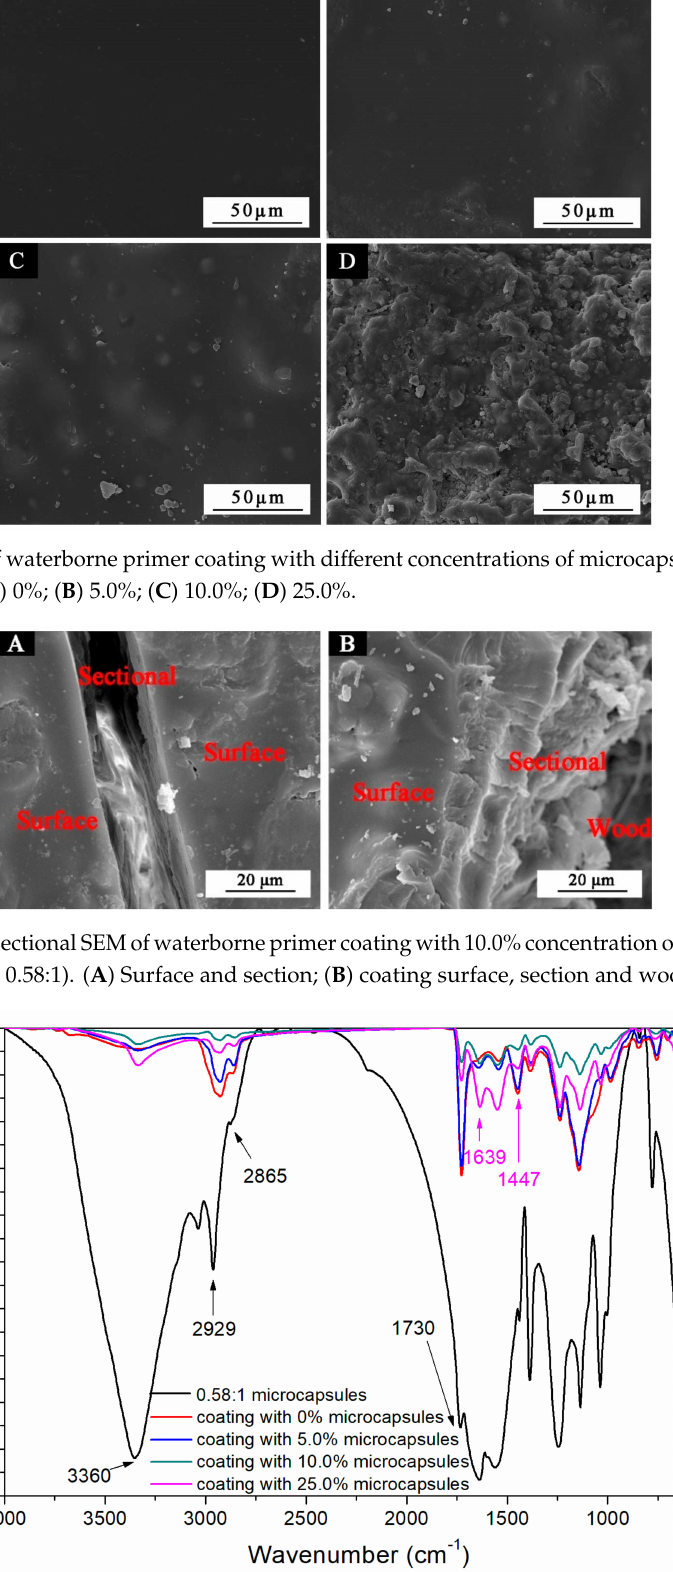
Figure 13. FTIR of waterborne primer coating with di ff erent concentrations of microcapsules (the core–wall ratio is